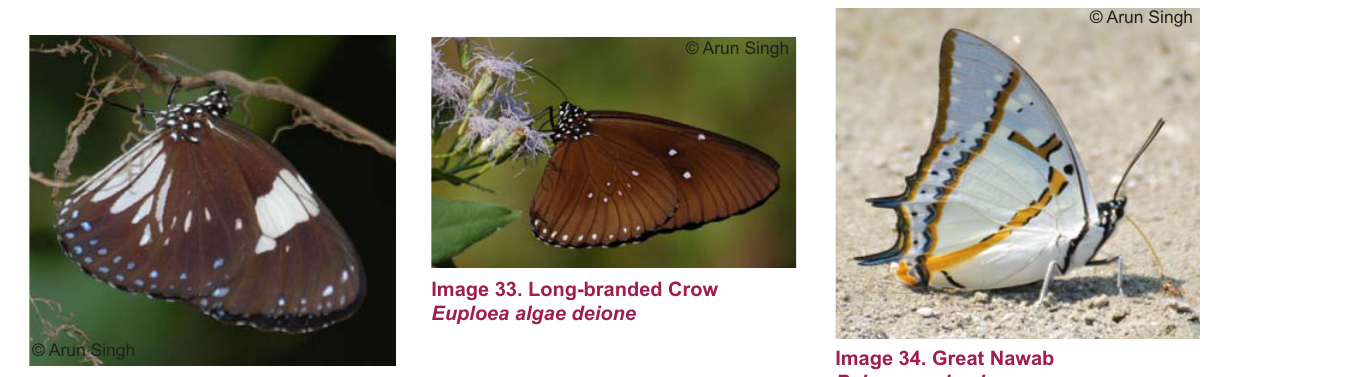
Image 32. Magpie Crow Euploea radamanthus